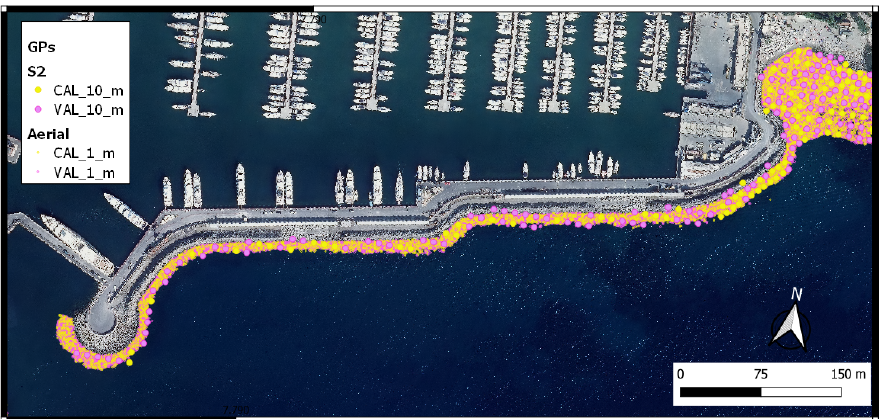
Figure 7. Portosole MBES points used for calibration (40%—in yellow) and validation (60%—in pink) of two different platforms, i.e., aircraft and S-2, respectively, at 1 m and 10 m resampling grids (aircraft orthophoto as